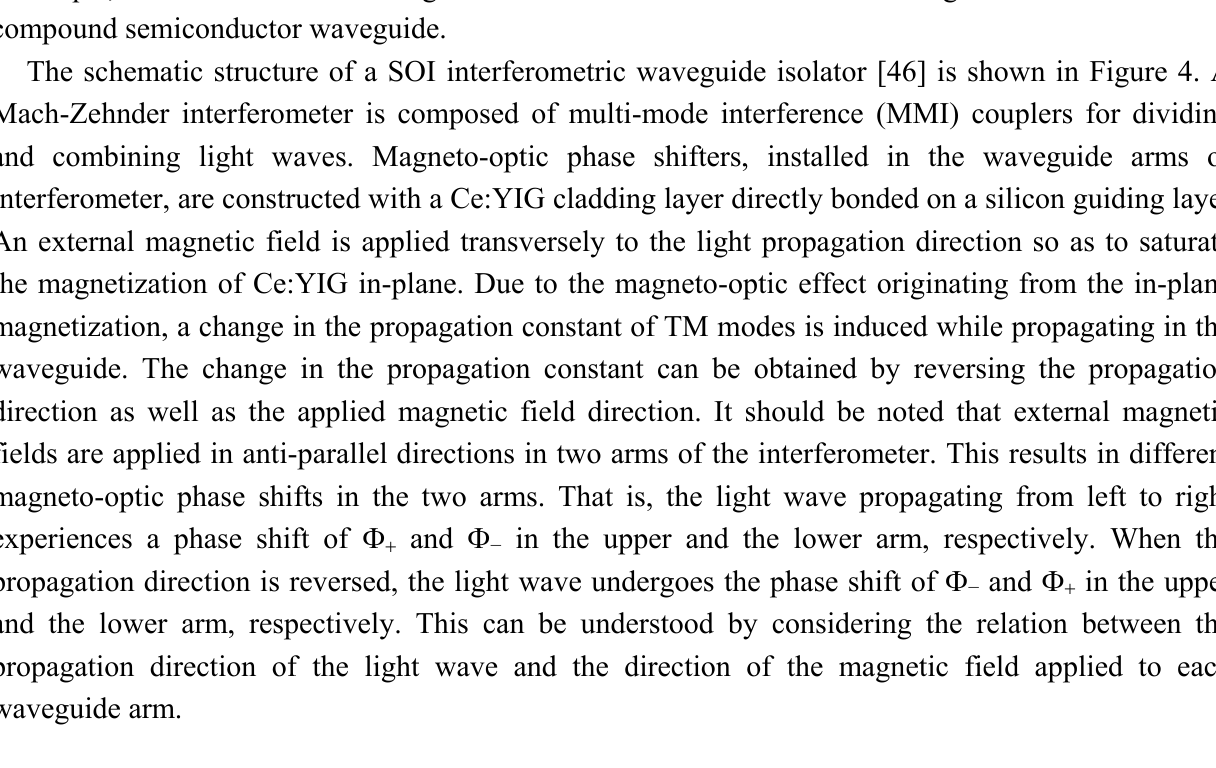
Figure 4. The schematic drawing of SOI interferometric waveguide optical isolator